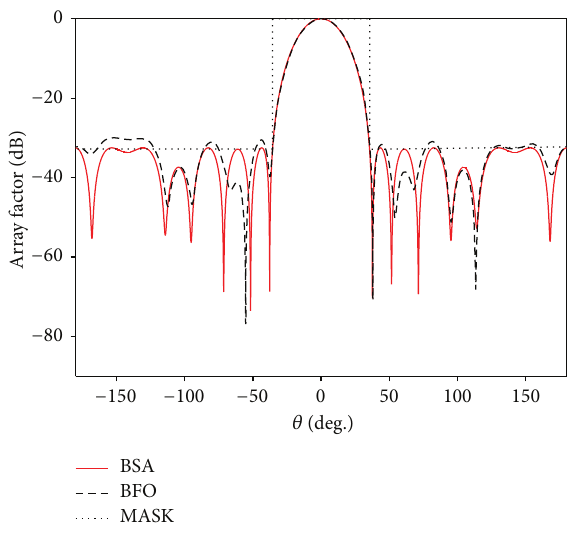
Figure 10: The radiation patterns obtained by BSA and BFO [3] for CCAA without central element.